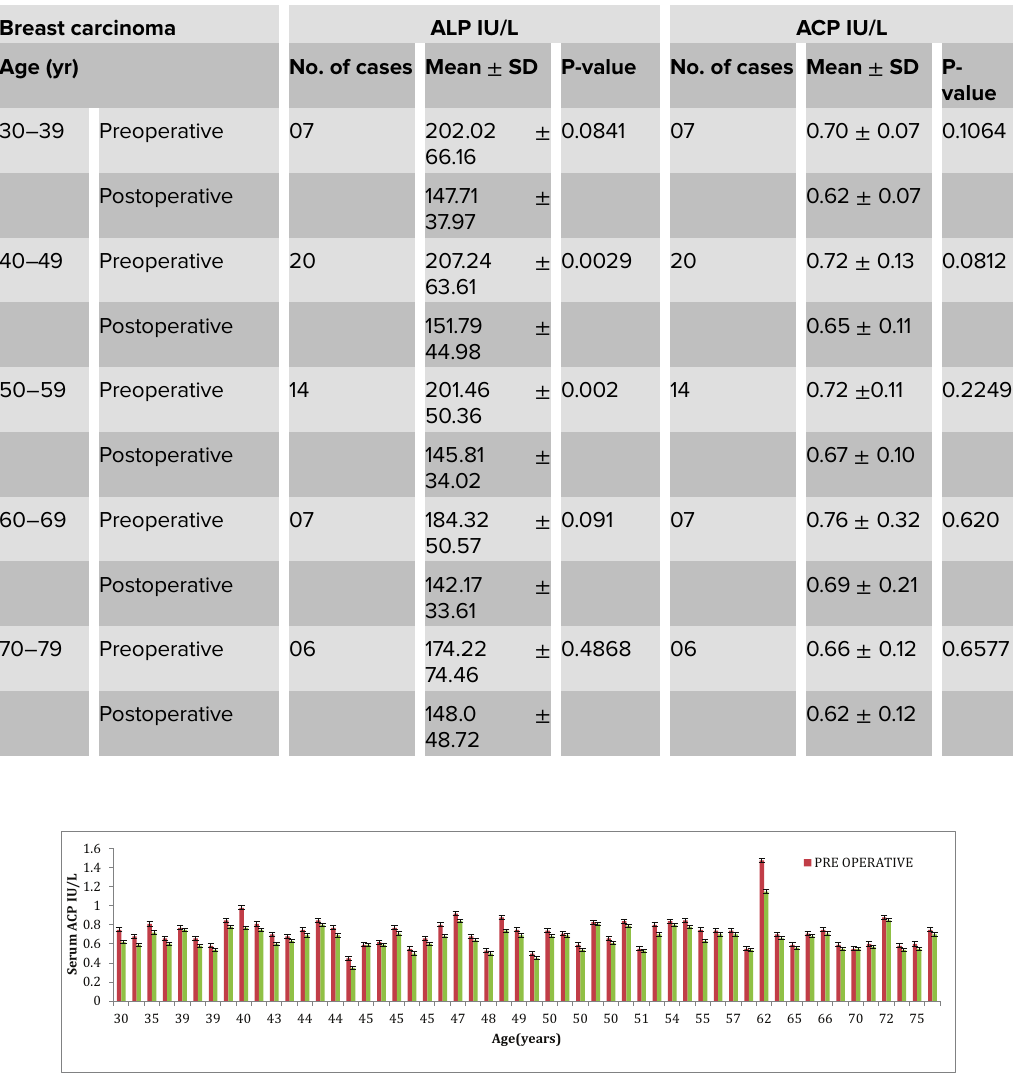
Table 3: Comparison of pre and postoperative levels of serum ALP and ACP in different age groups of breast carcinoma.